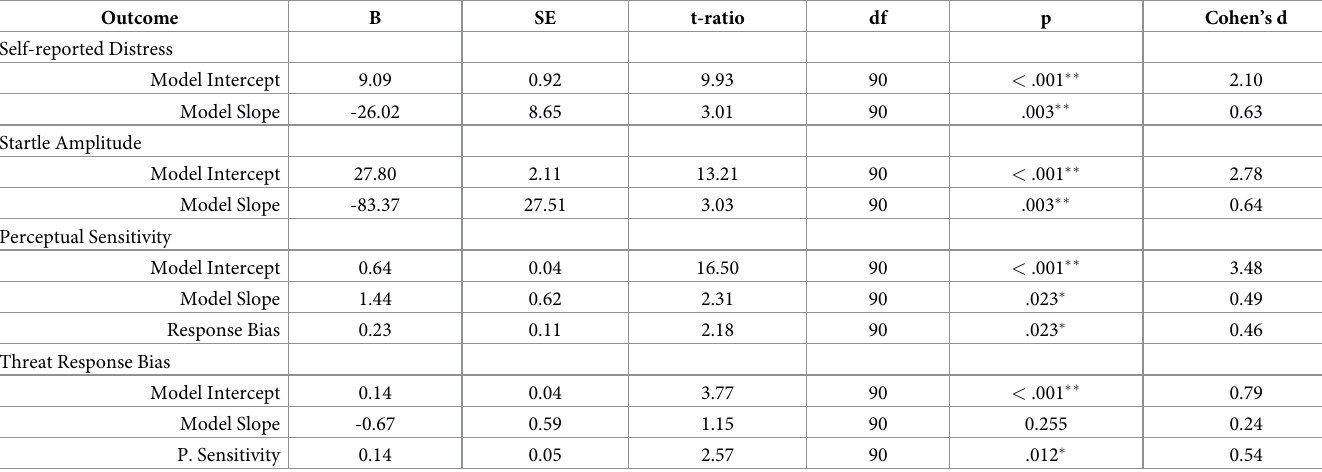
Table 2. Changes in Affective Tone of Recent Marathon-related Coverage Predicts Distress, Startle Reactivity, Perceptual Sensitivity, and Shooting Behavior. Outcome